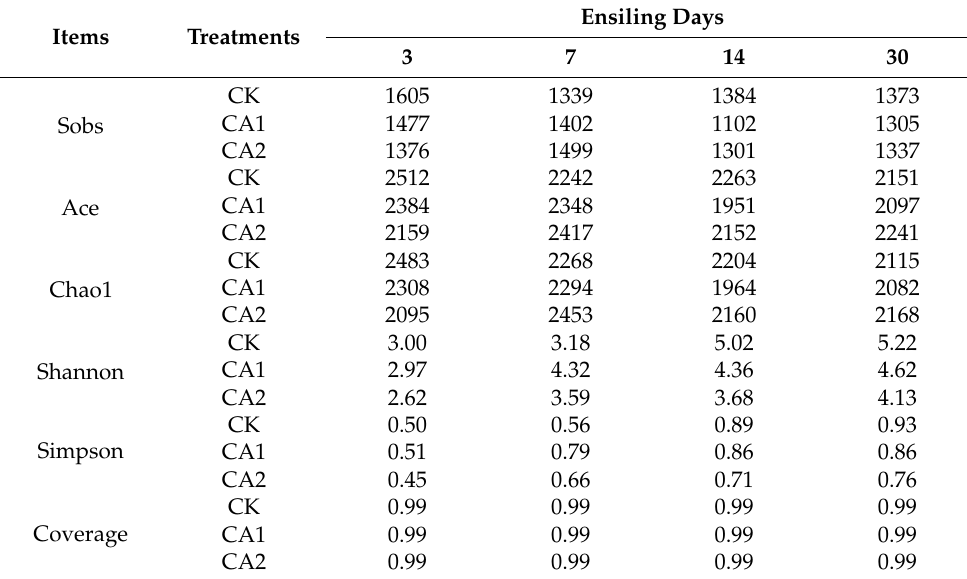
Table 5. Alpha diversity of the bacterial community for mulberry leaf